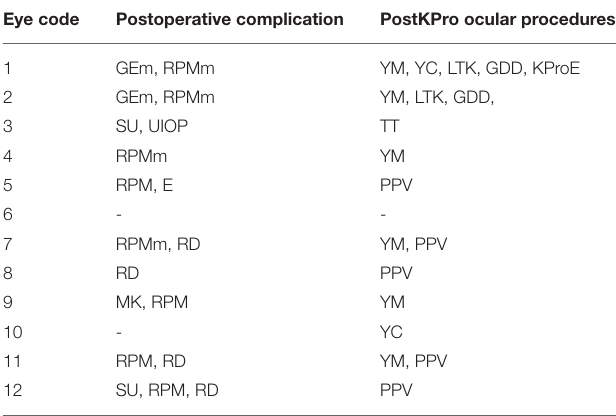
TABLE 2 | Individual data of postoperative complications and procedures. Eye